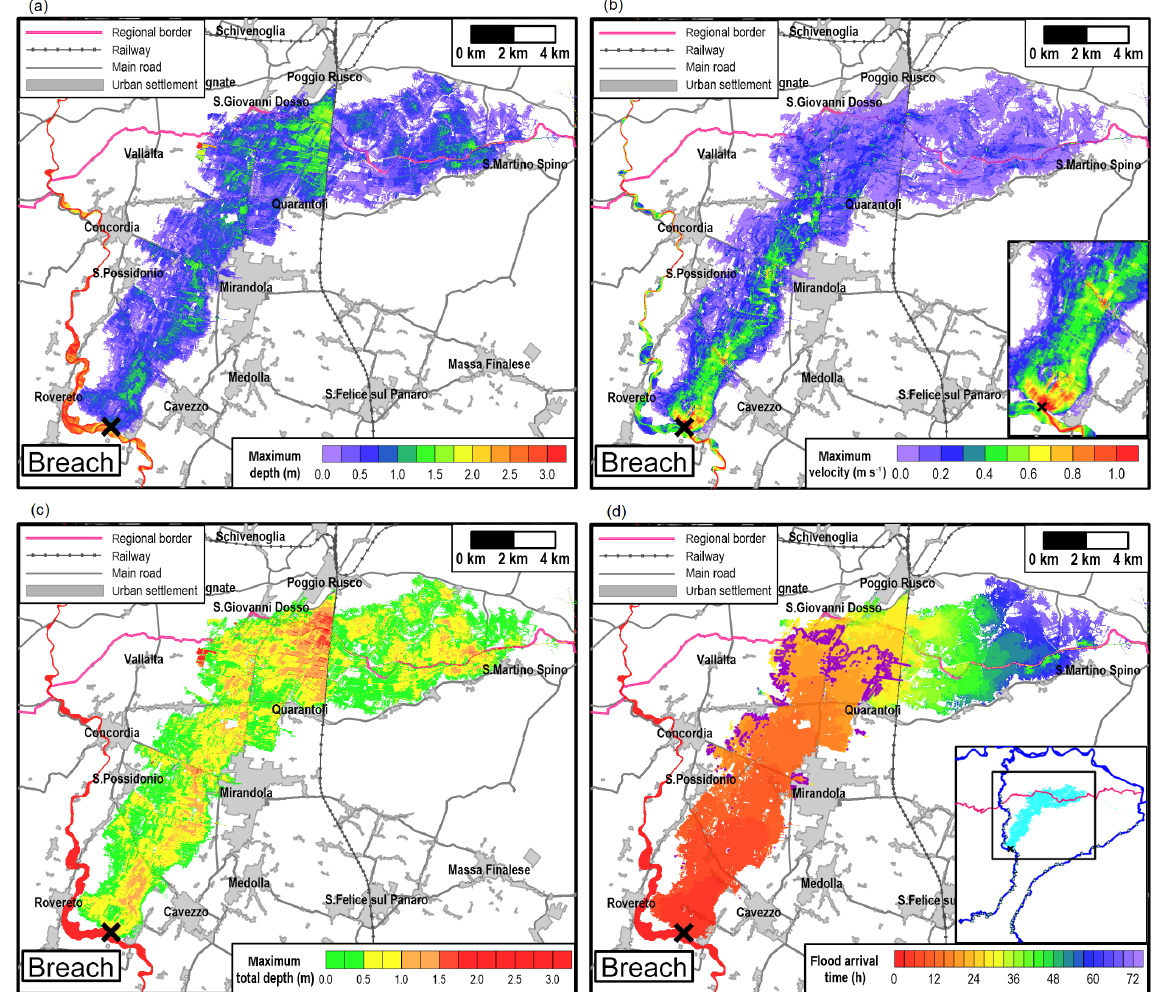
Figure 3. Example of the resulting maps concerning the maximum (a) water depth, (b) velocity, (c) total depth and (d) flood arrival time for a given scenario on the Secchia River with inflow B. The main roads, railways and urban settlements are identified, and the breach location is indicated with a black cross. The topographic information in background is made available by Emilia-Romagna region at https: //geoportale.regione.emilia-romagna.it/it (last access: 8 January